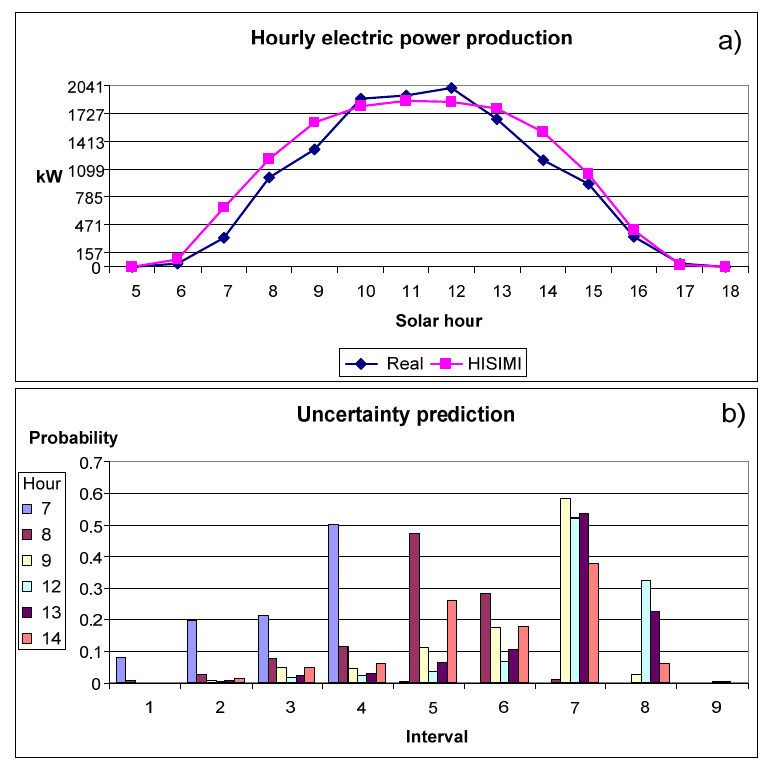
Figure 10. Forecasted production of hourly power ( a ) and uncertainty prediction for six hours; ( b ) on a partly cloudy day.